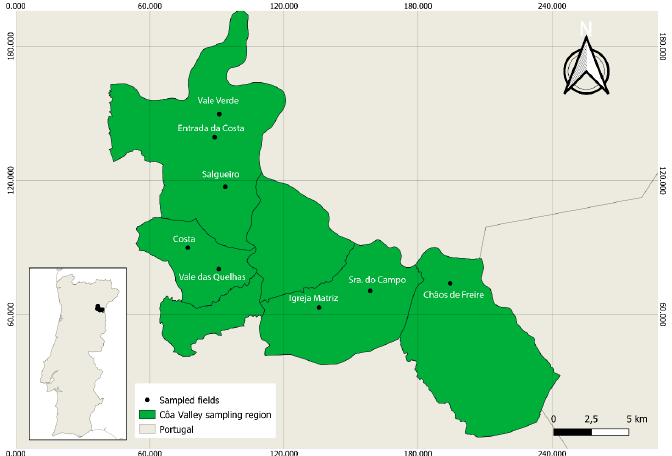
Figure 5. Côa Valley sampling region with the indication of sampling fields. Map projected in